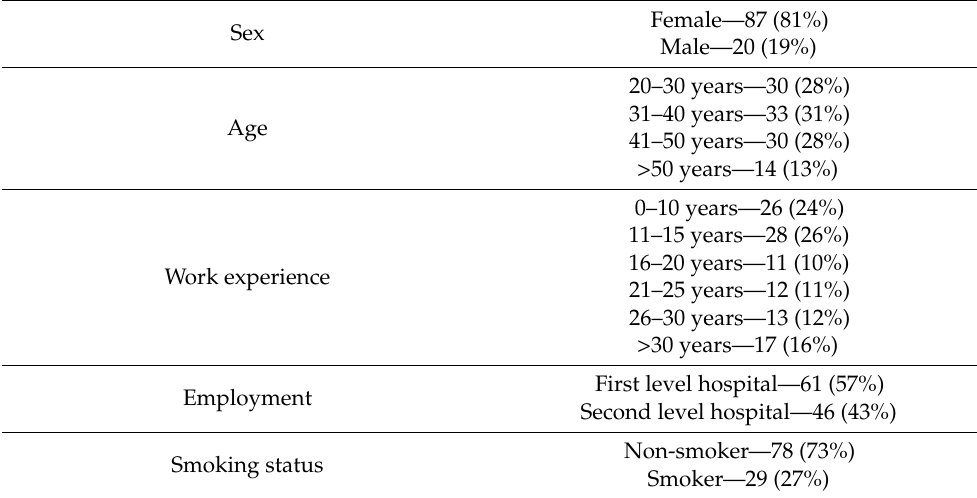
Table 1. Demographic characteristics of study participants (n = 107).